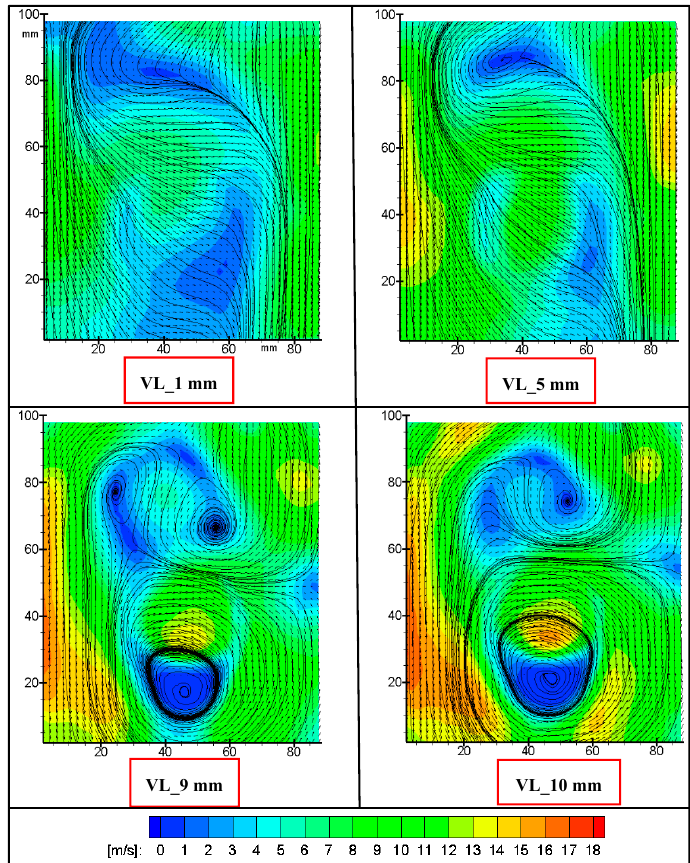
Figure 7. Ensemble-averaged velocity vectors at different valve lifts.